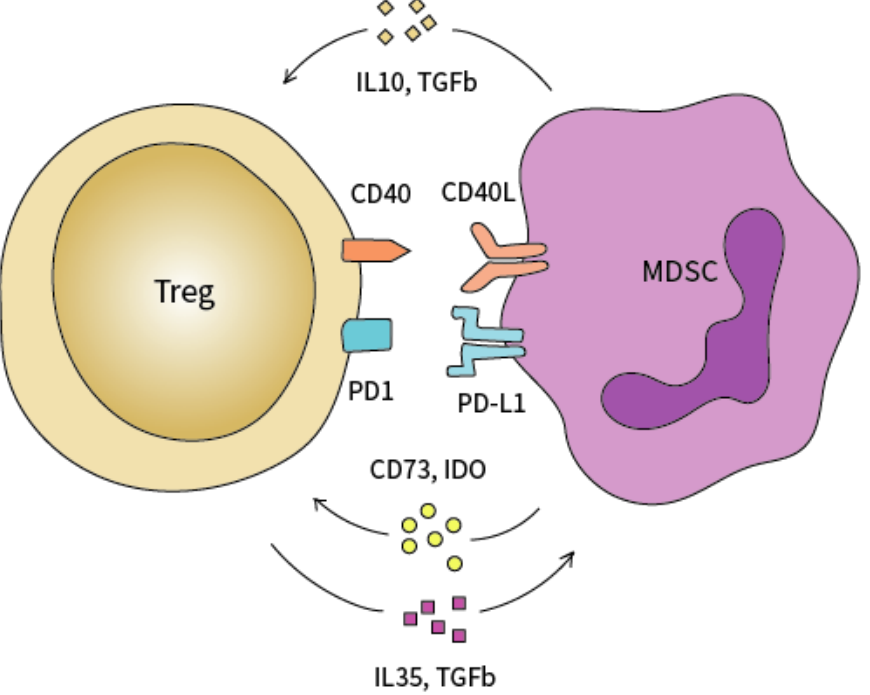
Figure 2. Functional crosstalk between Tregs and MDSC. MDSCs attract Tregs into the tumor microenvironment via TGF- β, IL10, CD73, and IDO secretion. Tregs modulate the expansion of MDSCs through the secretion of IL-35 and TGF- β.